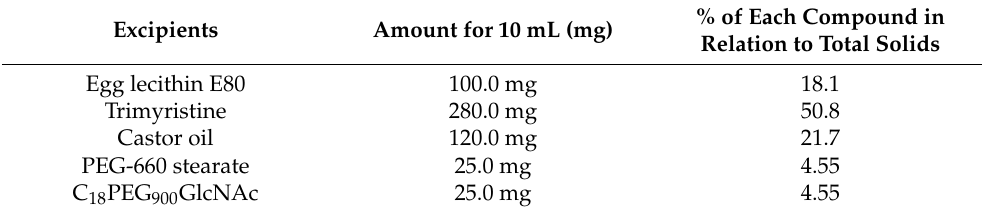
Table 1. Composition of the nanocarriers NLC prepared with the association of the PEG-660 stearate and modified surfactant (C 18 PEG 900